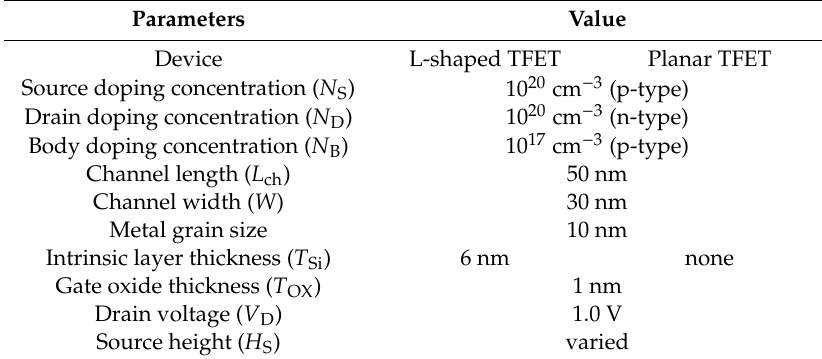
Table 1. Device parameters of devices used for technology computer-aided design (TCAD) simulation.